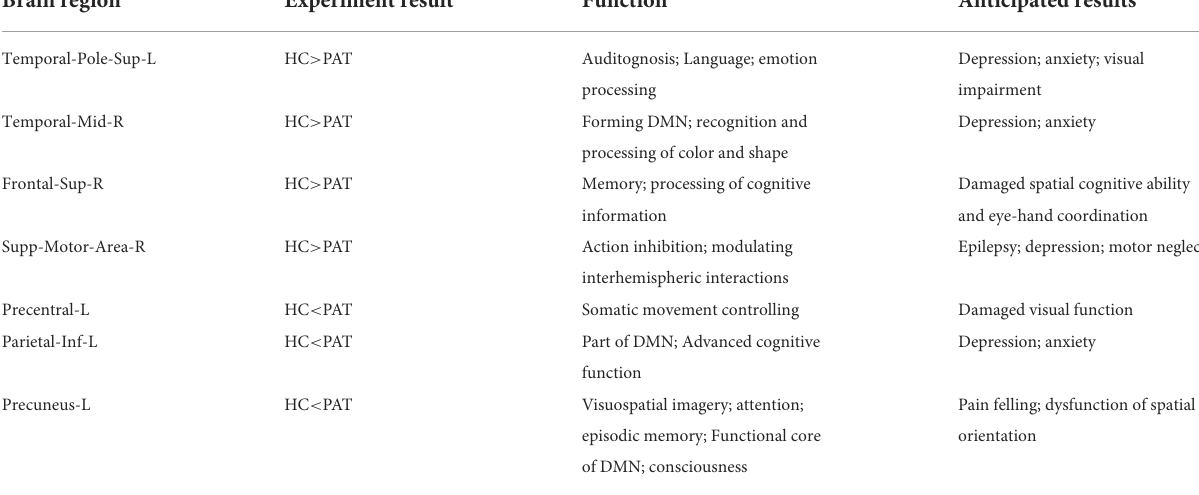
TABLE 3 The function of brain regions with altered fALFF values and its clinical